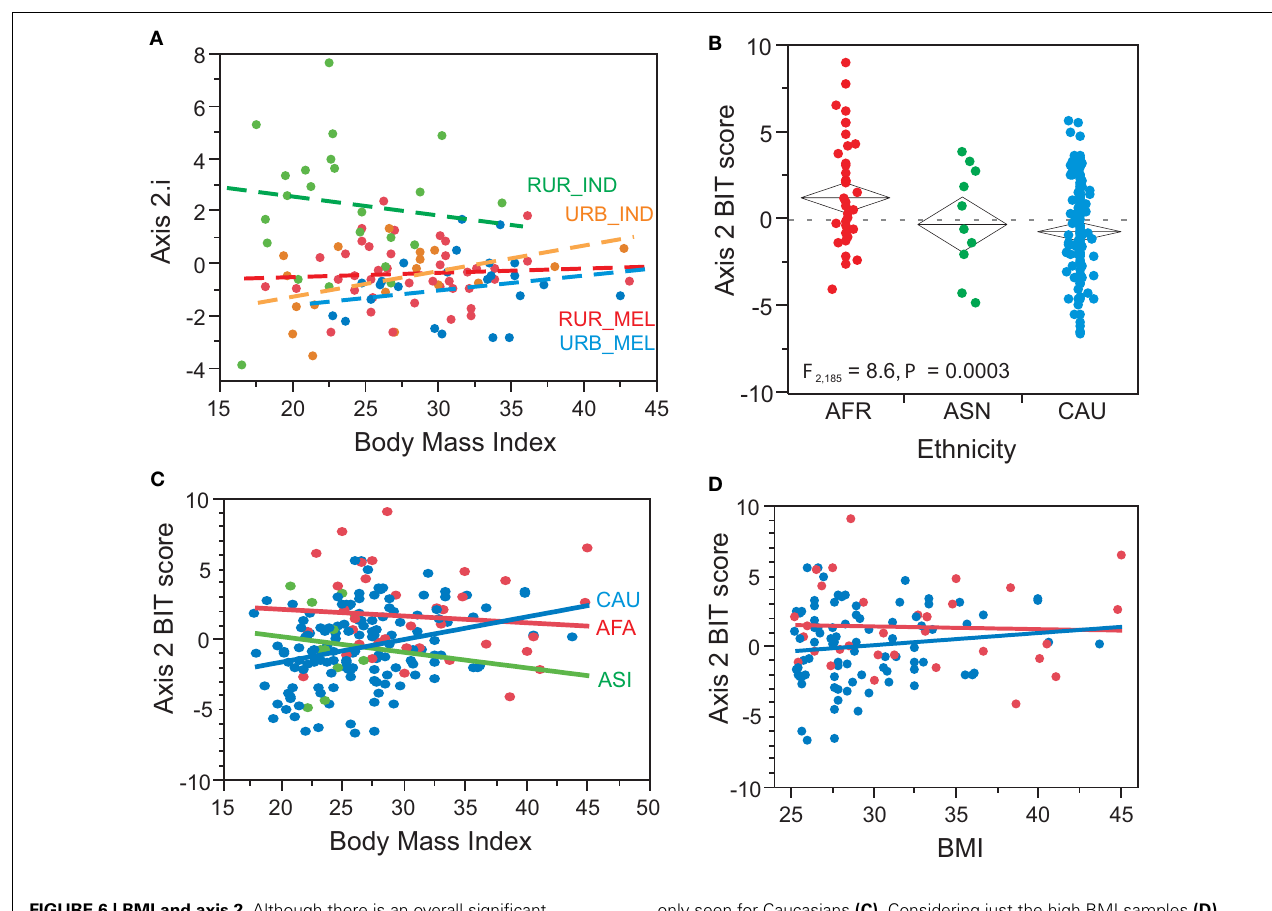
FIGURE 6 | BMI and axis 2. Although there is an overall significant correlation between BMI and Axis 2 ( p = 0.03), it appears to be driven largely by the low BMI in most of the rural Indians (A) , as the correlation is not observed in each population considered alone. In our Atlanta Center for Health Discovery andWell-being study (Gibson, 2008), African Americans have significantly elevated Axis 2 scores relative to Asians and Caucasians (B) , but the significant regression of BMI on Axis 2 is